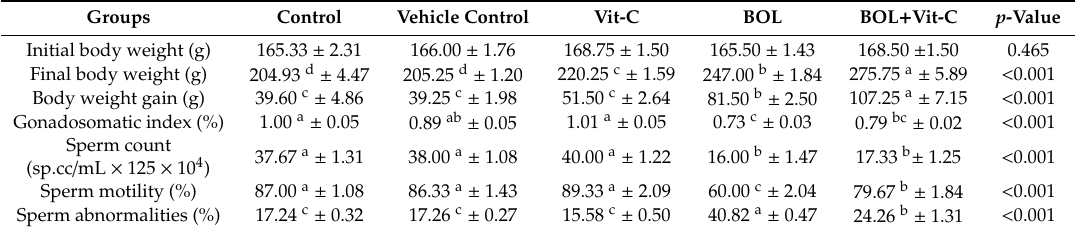
BOL: boldenone and Vit-C: vitamin C. A one-way analysis of variance (ANOVA) followed by Duncan’s Multiple Range test was used for statistical analysis. Means within the same row carrying di ff erent superscripts ( a–d ) are significantly di ff erent. The values shown are means ± SE. n =